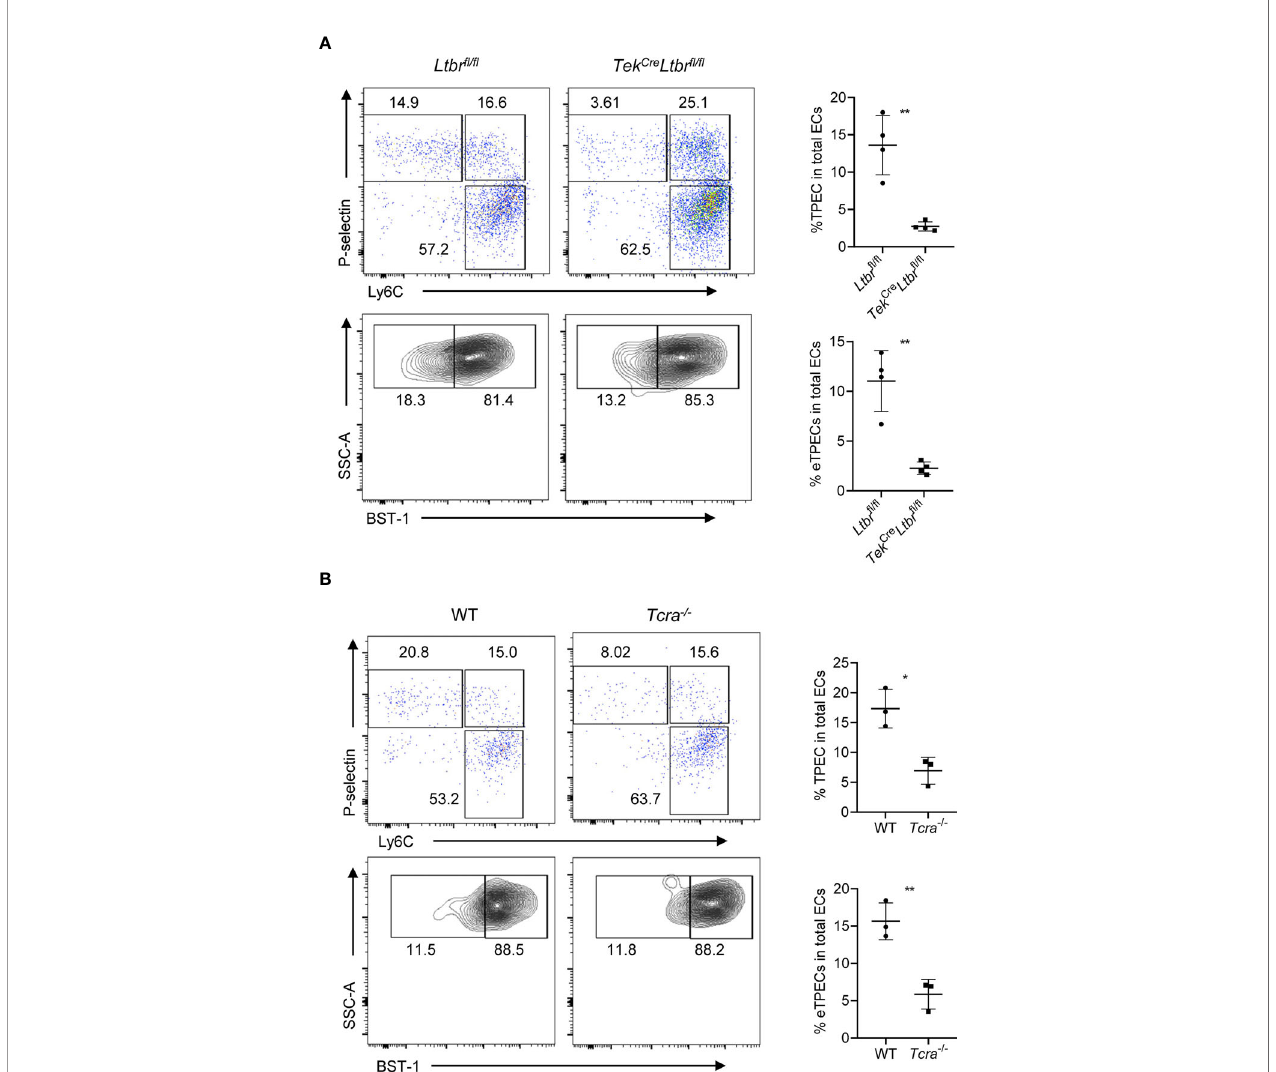
FIGURE 9 | LT b R signaling and T cells regulate the development of eTPECs. (A) Flow cytometric analysis of TPEC and eTPECs in Ltbr fl / fl and Tek Cre Ltbr fl / fl mice. Left: Representative plots are shown. Right: Graphs display the statistical analysis of the percentage of TPECs or eTPECs. Mean ± SEM; n = 4. Data are representative of at least three independent experiments. (B) Flow cytometric analysis of TPEC and eTPECs in WT and Tcra − / − mice. Left: Representative plots are shown. Right: Graphs display the statistical analysis of the percentage of TPECs or eTPECs. Mean ± SEM; n = 3. Data are representative of two independent experiments. *P < 0.05; **P < 0.01 (unpaired Student ’ s t